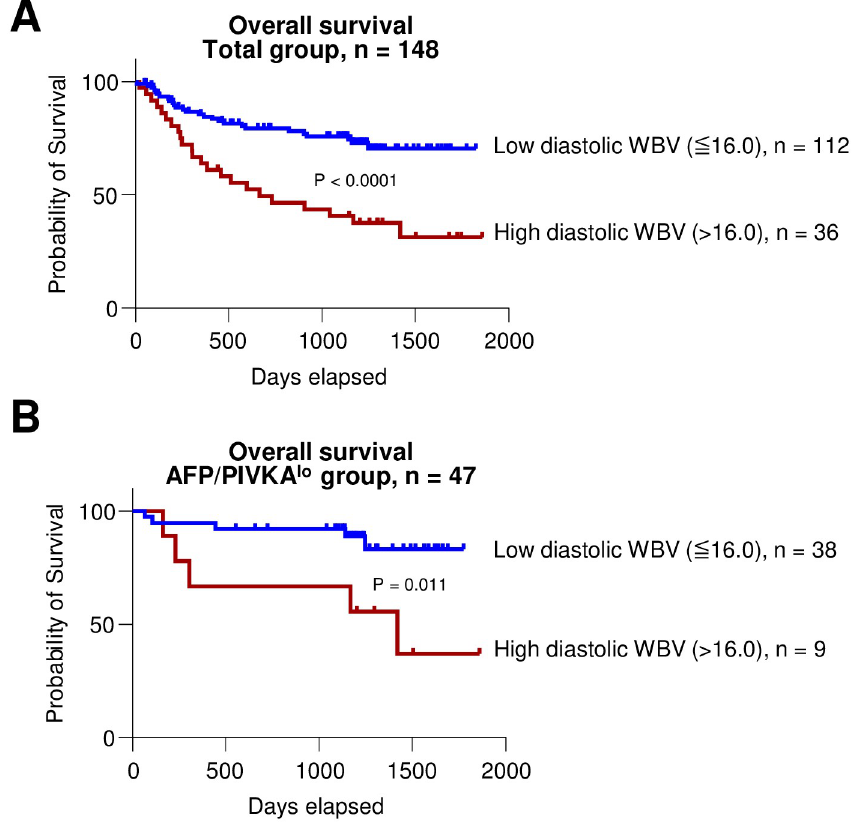
Fig 3. (A and B) Kaplan-Meier curves for comparing OS between low diastolic WBV ( � 16.0) and high diastolic WBV ( > 16.0) groups in all patients (n = 148) (A) and in patients with low AFP/PIVKA (AFP < 20 ng/mL and PIVKA < 40 mAU/mL) (n = 47)